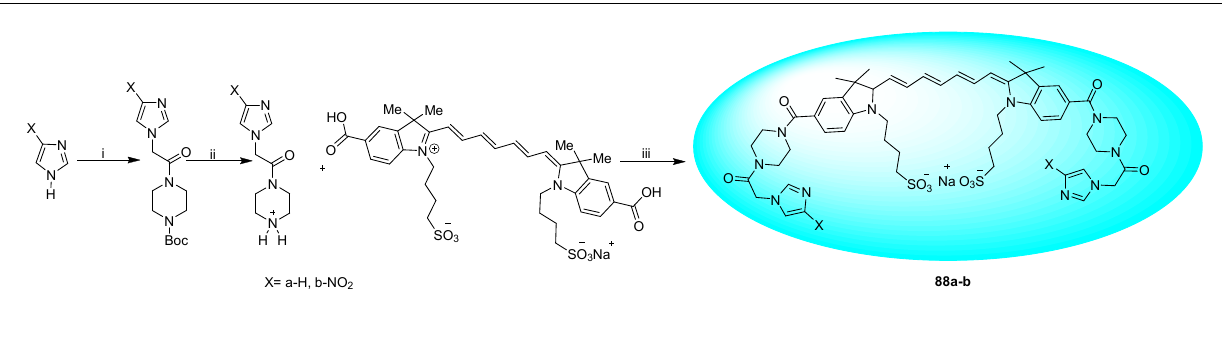
Scheme 27. Synthesis of 2-azido-4-nitroimidazoles. Reagents and conditions: ( i ) NaNO 2 , NaN 3 , H 2 SO 4 , 78%; ( ii ) KHCO 3 , TBAB, IPA, 6 h, 85 ◦ C, 72% and 76%.